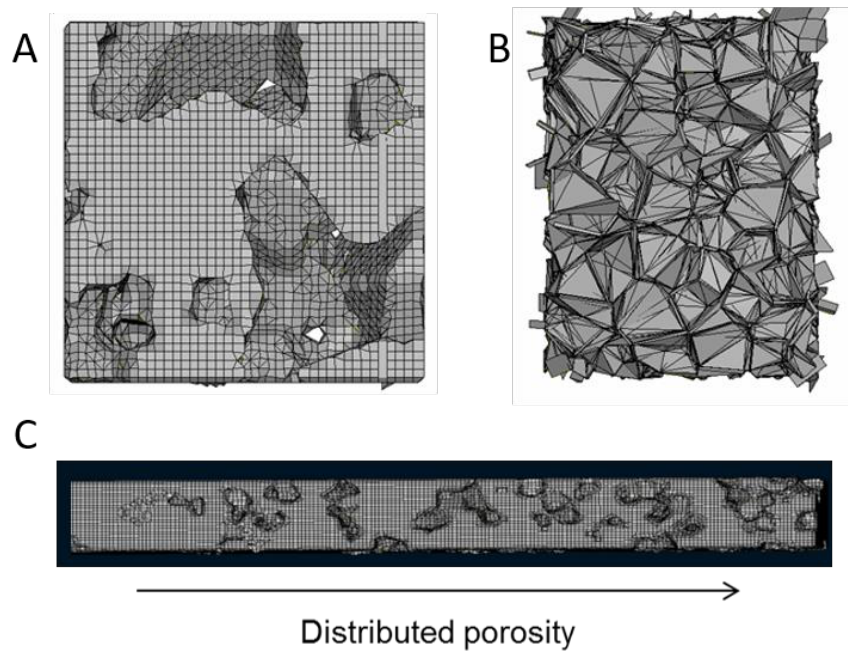
Figure 2. ( A ) porous structure produced by Voronoi cells following a size distribution, ( B ) closed cell foam produced by adding thickness to 3D Voronoi cells, ( C ) porous structure with varying cell porosity.